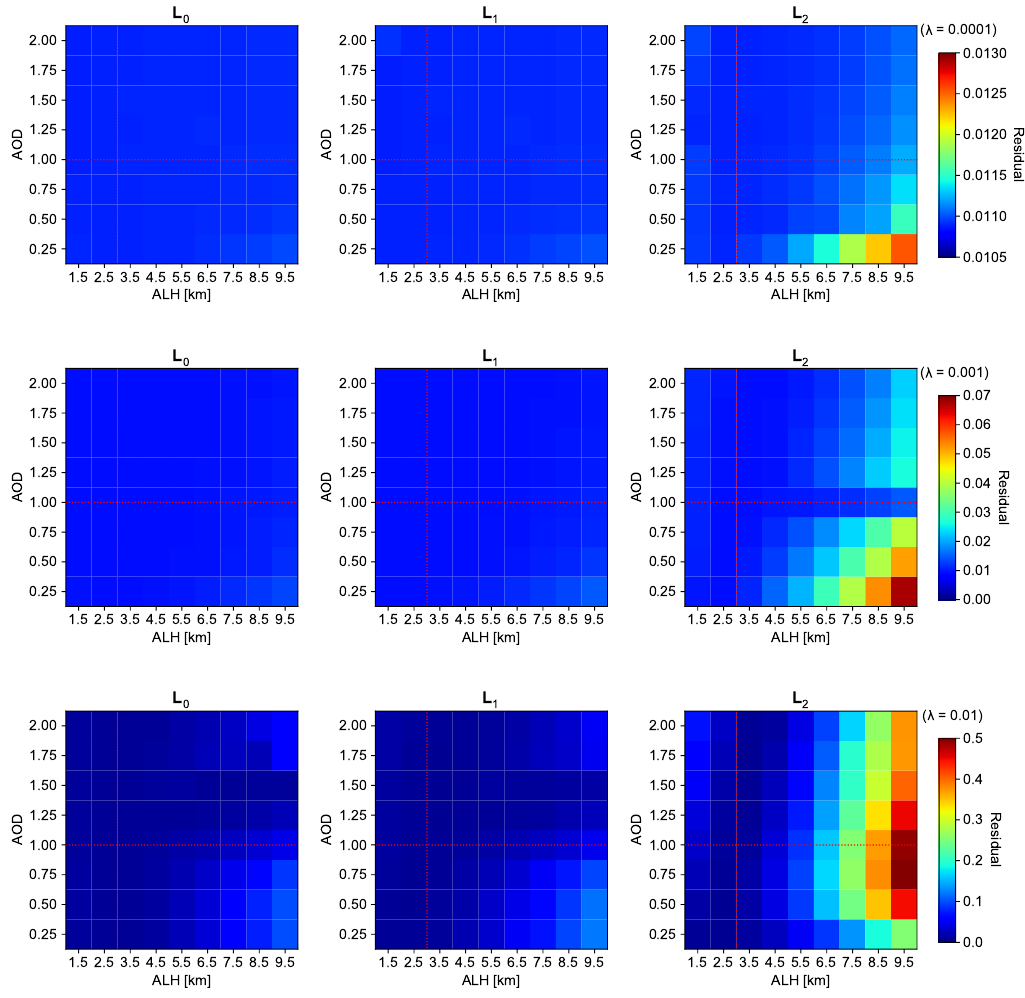
Figure 5. Residual after convergence corresponding to three regularization matrices. The x - and y -axes represent the true values of ALH and AOD, respectively. The values of λ is displayed above each color bar. The dotted red lines refer to the a priori values of ALH and